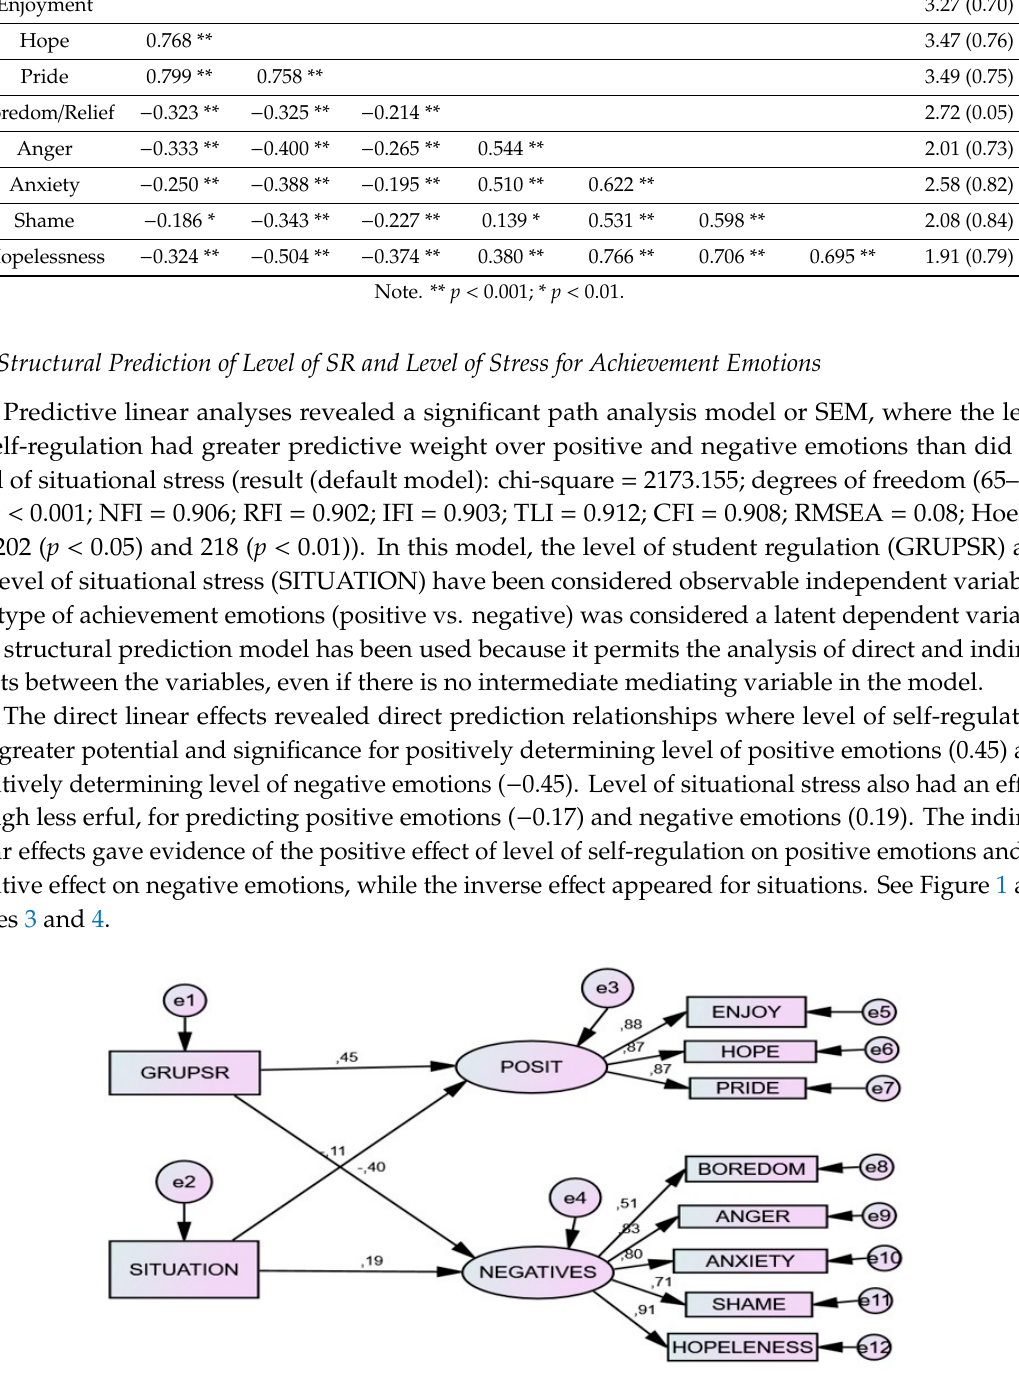
Figure 1. Predictive structural relationship of self-regulation level and situational stress level on achievement emotions. Note: GRUPSR = self-regulation Level: 1 (low), 2 (medium) and 3 (high). SITUATION = 1 (class), 2 (study) and 3 (test). POSIT = positive achievement emotions (enjoy, hope and pride) and NEGAT = negative achievement emotions (boredom, anger, anxiety, shame and hopelessness).